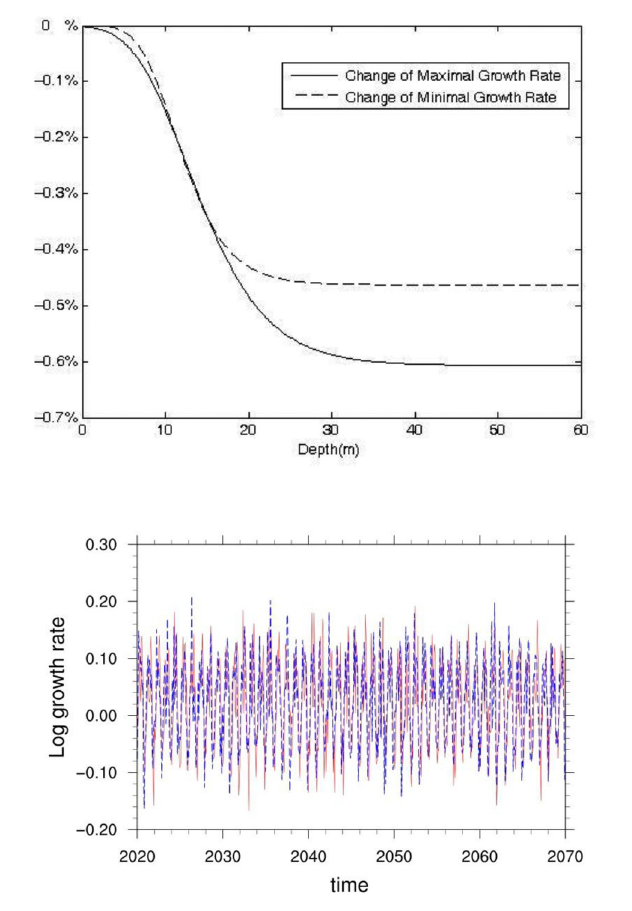
Projected coral growth rate in 2020- 2070 under RCP4.5 (red line) and geoengineering (blue line)